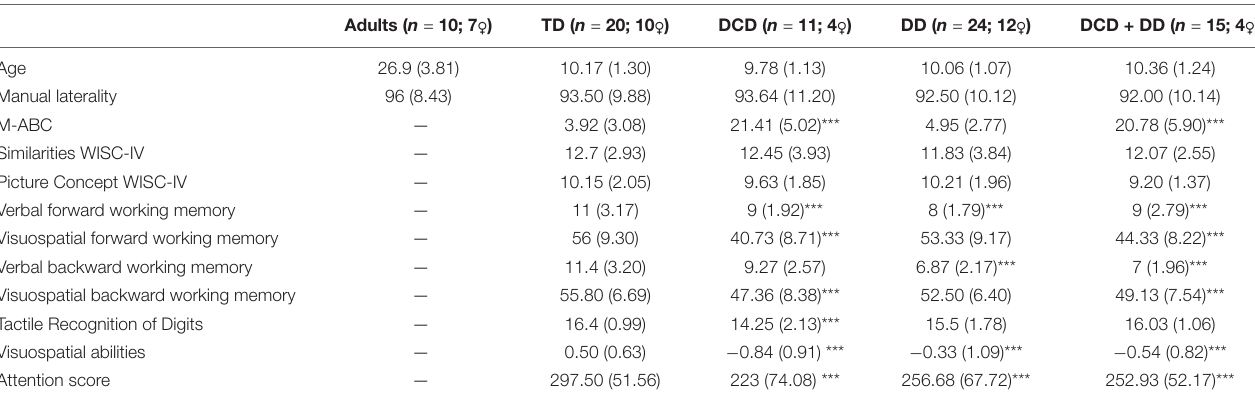
TABLE 1 | Means and standard deviation of scores of neuropsychological tests of all